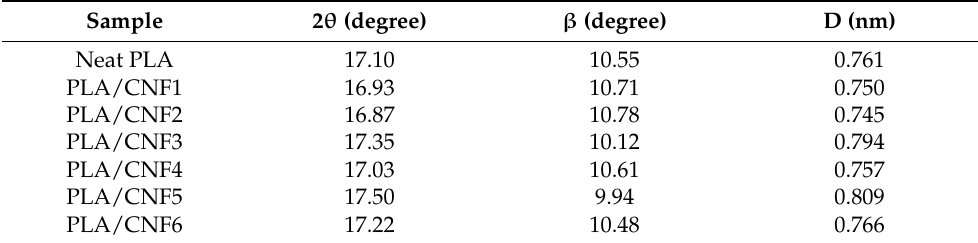
Figure 6. XRD diffraction patterns of neat PLA and PLA/CNF nanocomposites. Table 4. PLA crystallite size in nanocomposites at various CNF